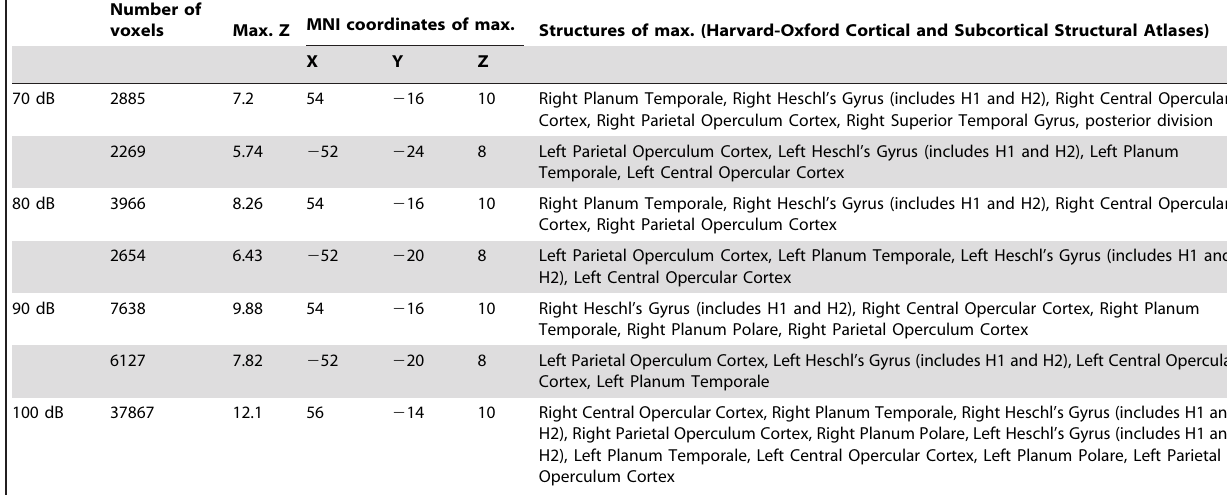
Table 2. Clusters exhibiting activation with the 70, 80, 90 and 100 dB tones in the fMRI data analysis. Structures defined according to the Harvard-Oxford Cortical and Subcortical Structural